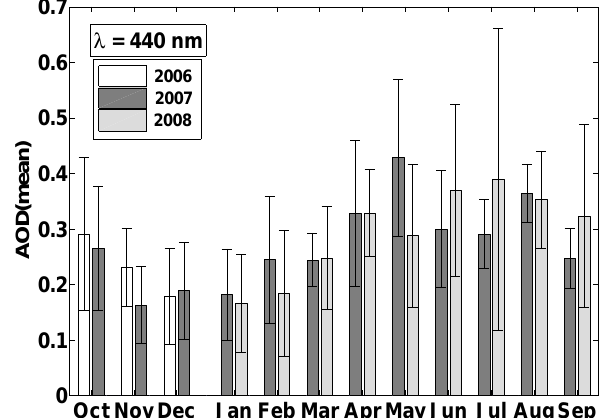
Fig. 2. Temporal evolution of AOD (440nm) daily averages in Zan- jan, October 2006 to September 2008, the IASBS site.